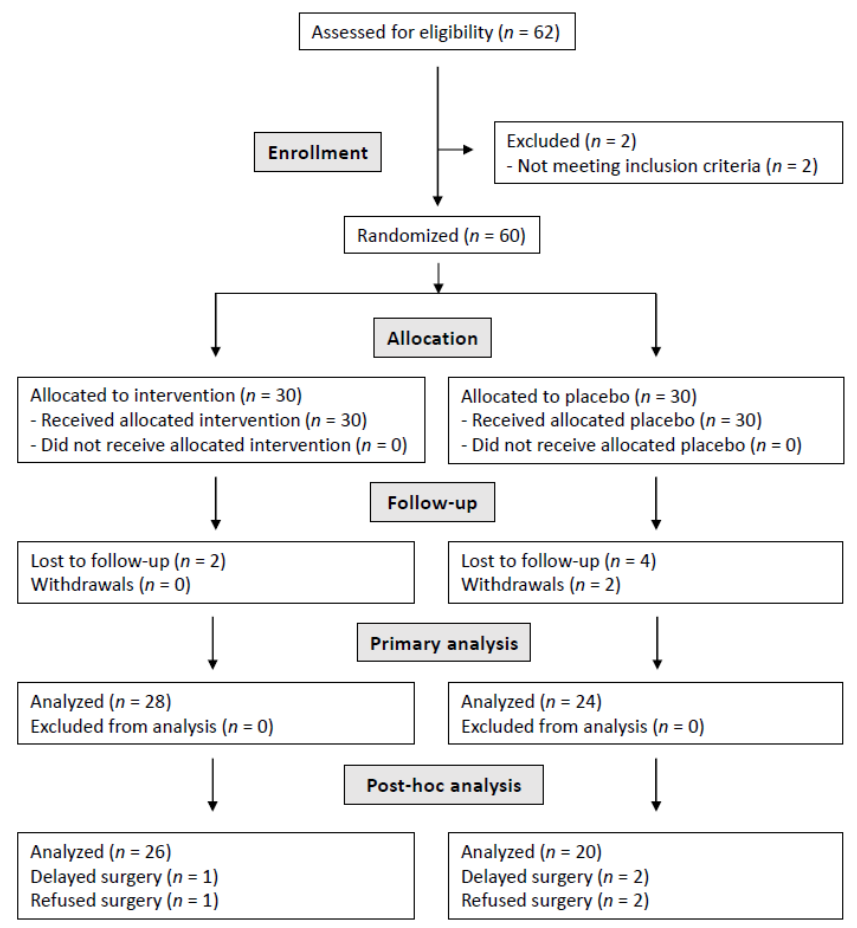
Figure 1. Study flow diagram.